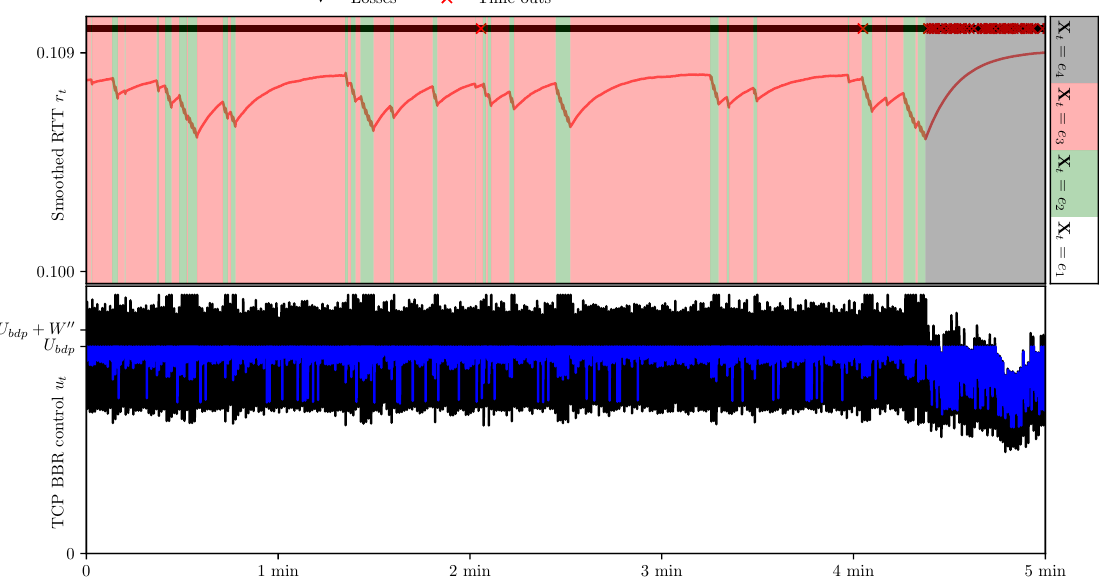
Figure 5. TCP channel simulation example for BBR control